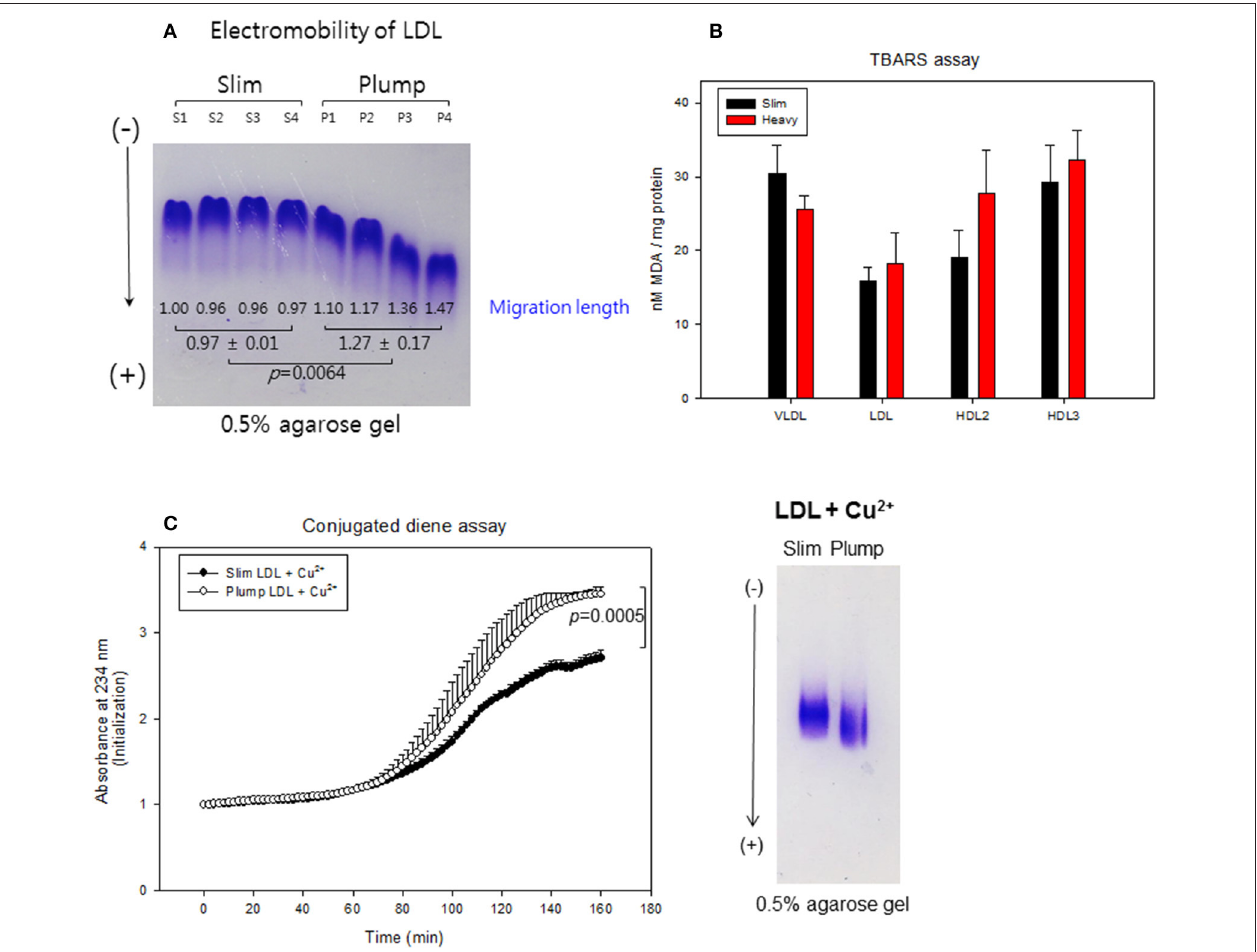
FIGURE 7 | Lipoprotein properties between slim and plump groups. Electromobility of LDL (A) , extent of oxidized species (B) . Susceptibility to cupric ion mediated oxidation (C) .